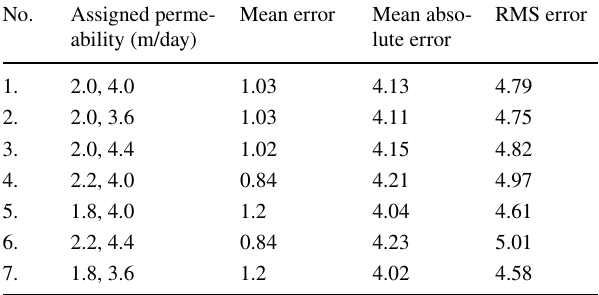
Table 2 Sensitivity analysis for permeability (K) variance No. Assigned perme- ability